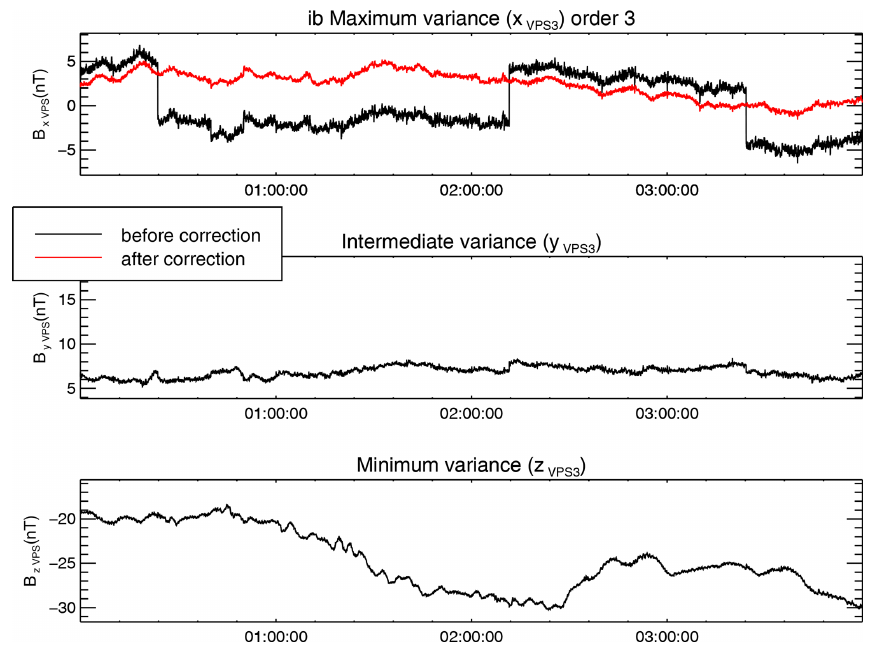
Figure 6. The second- (black) and the third-order correction (red) for the inboard FGM sensor. Mean values were subtracted.